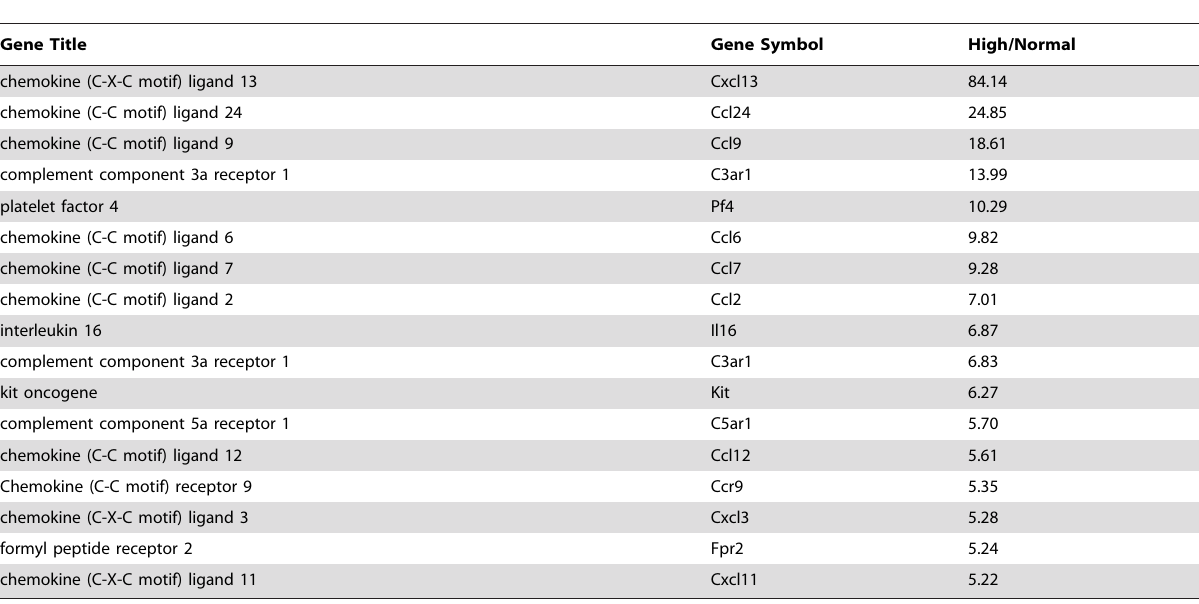
Table 2. Upregulated genes ( . 5-fold) classified as ‘immune response